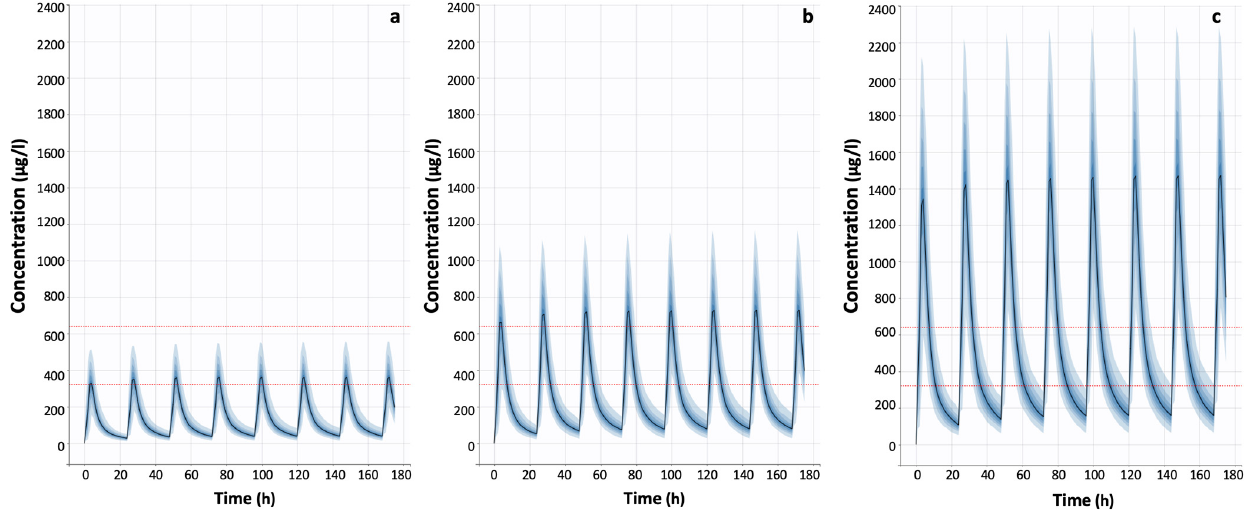
Figure 4. Simulated steady-state concentration to time profiles (7 days) after oral administration of amisulpride doses obtained with the population model developed. Daily dosing regimen of ( a ) 200 mg, ( b ) 400 mg, and ( c ) 800 mg amisulpride. In each group, 1000 individuals were generated. The red dash lines represent the therapeutic maximum reference level and the laboratory alert level of amisulpride, 320 ng/mL and 640 ng/mL, respectively.